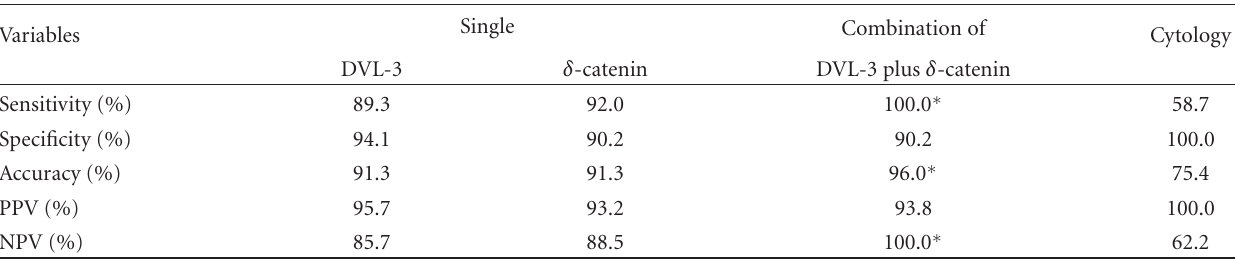
Table 4: Accuracy of RT-PCR for detection of DVL-3 mRNA, δ -catenin mRNA and combination of them compared with cytology for the diagnosis of lung